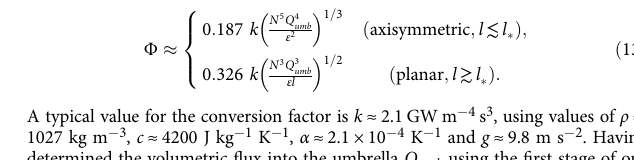
gravity. The two expressions for F 0 above yield